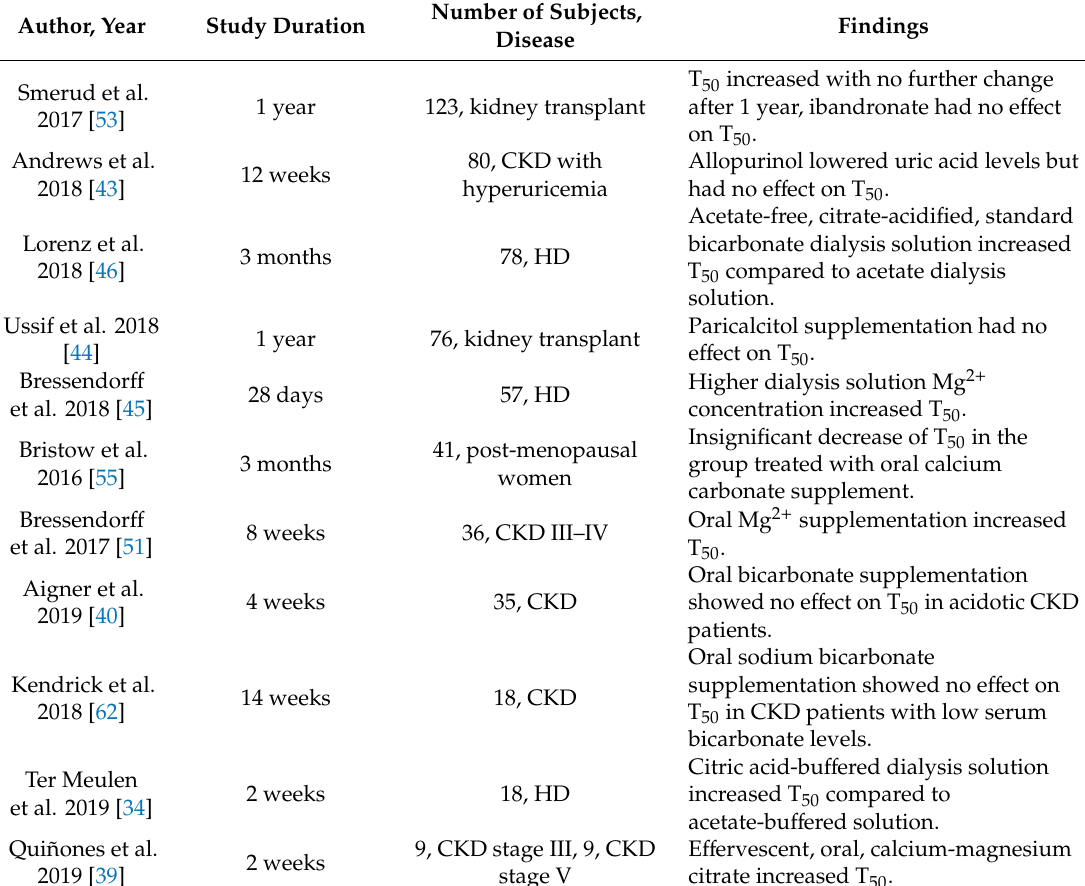
Table 4. Summary of 11 human interventional studies on T 50 with health